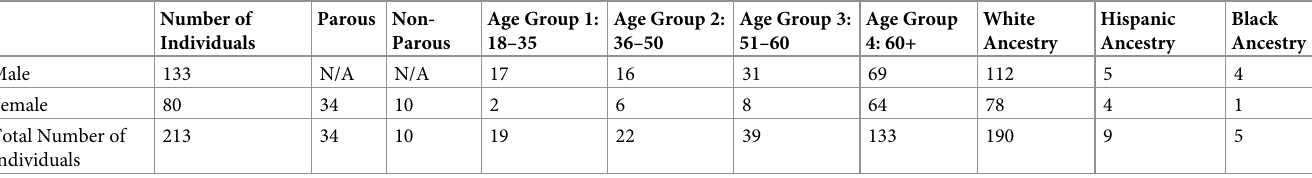
Table 2. Demographic